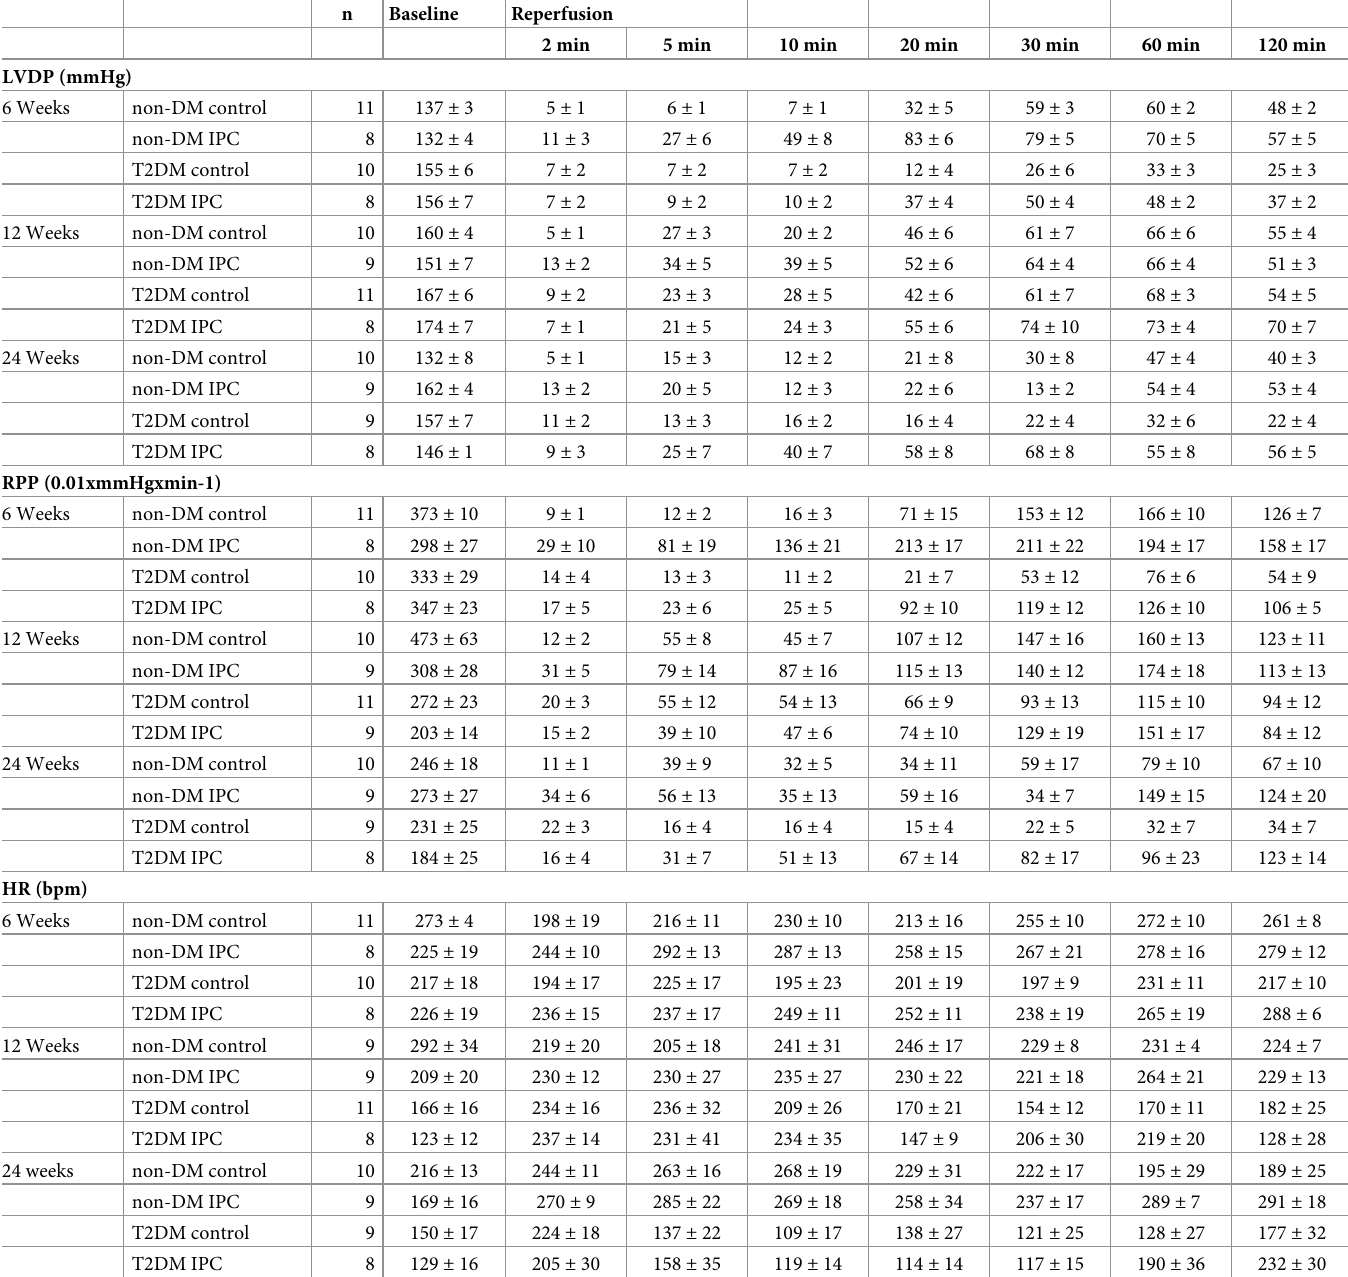
Table 2. Hemodynamic parameters preischemically and during